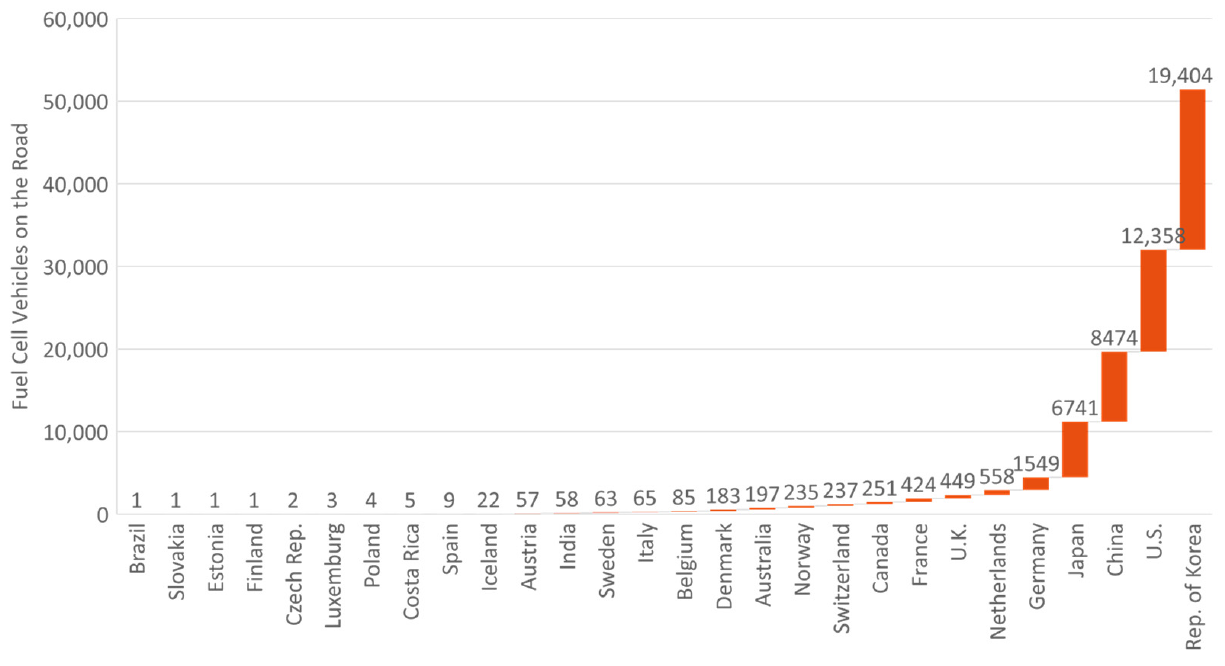
Figure 1 . Waterfall diagram showing the breakdown of all FCVs worldwide. Figure 1. Waterfall diagram showing the breakdown of all FCVs worldwide. Figure 2 shows the distribution of the 51,437 FCVs across different vehicle classes on the left-hand side and to different continents on the right. The pie chart on the left clearly shows that more than four out of every five FCVs are passenger cars. The remaining part is almost equally shared between buses and trucks, whereas medium-duty trucks have a higher share than heavy-duty ones. Light commercial vehicles make up the lowest share of all FCVs. The pie chart on the right indicates that more than two thirds of the vehicles are on the Asian roads, followed by one fourth being operated in North America. Europe has a rather low share of 7.7% of the worldwide fuel cell vehicle